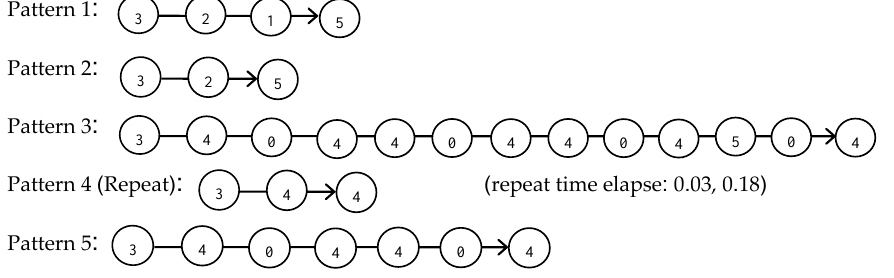
Figure 9. EEG patterns derived from entropy - based FP trees - I ( Table 3 data source)